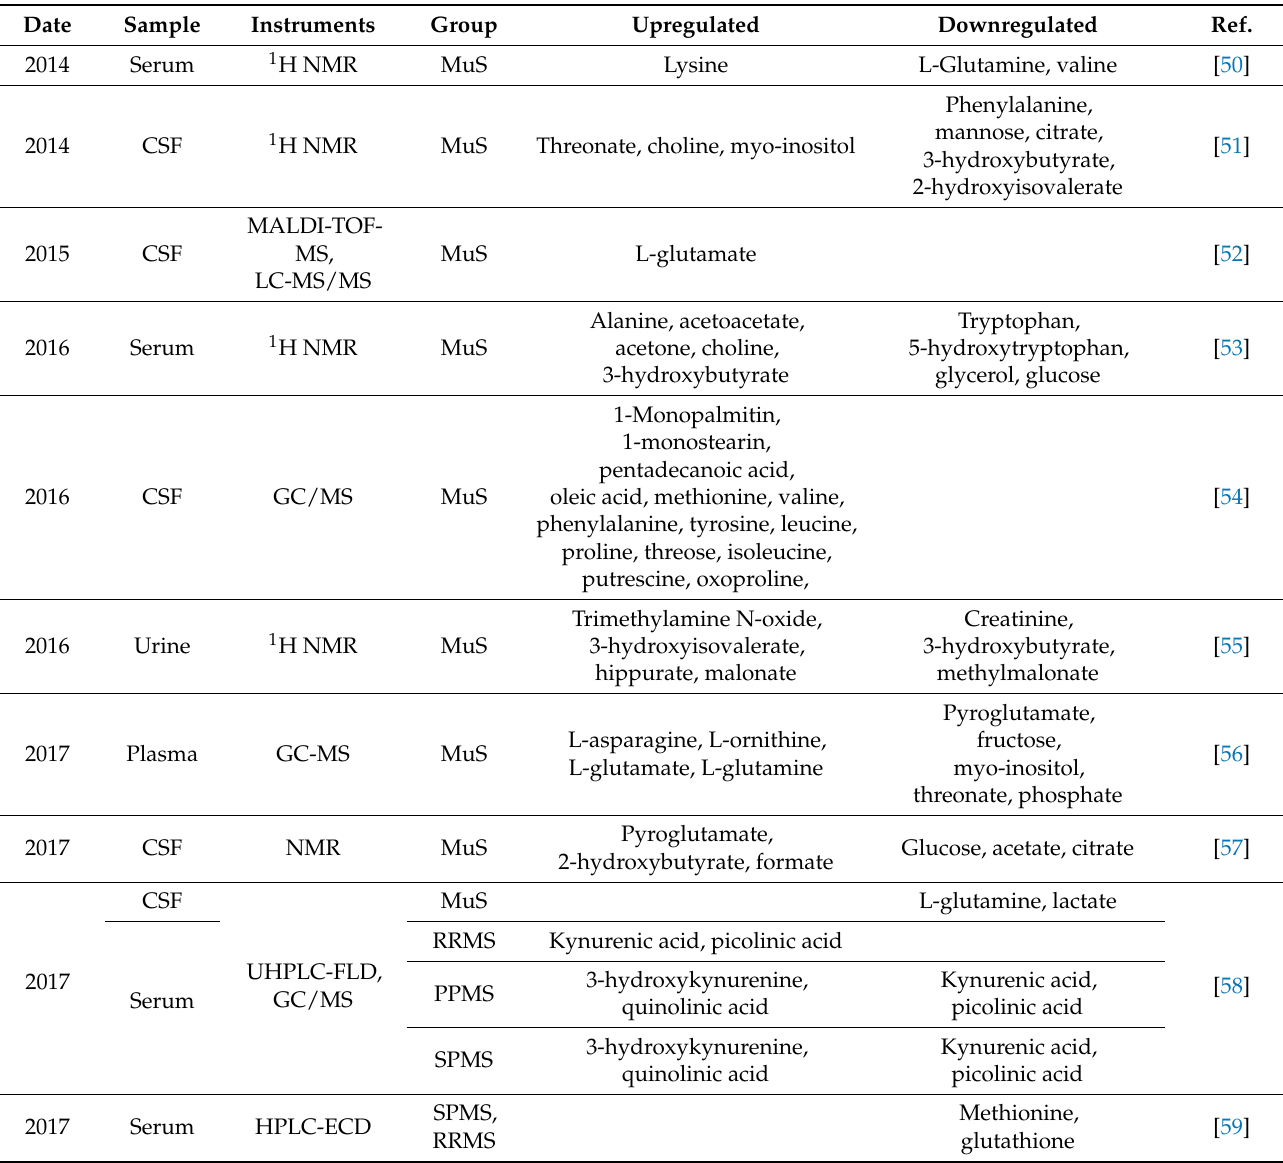
Table 2. Metabolic changes and related studies in patients with multiple sclerosis